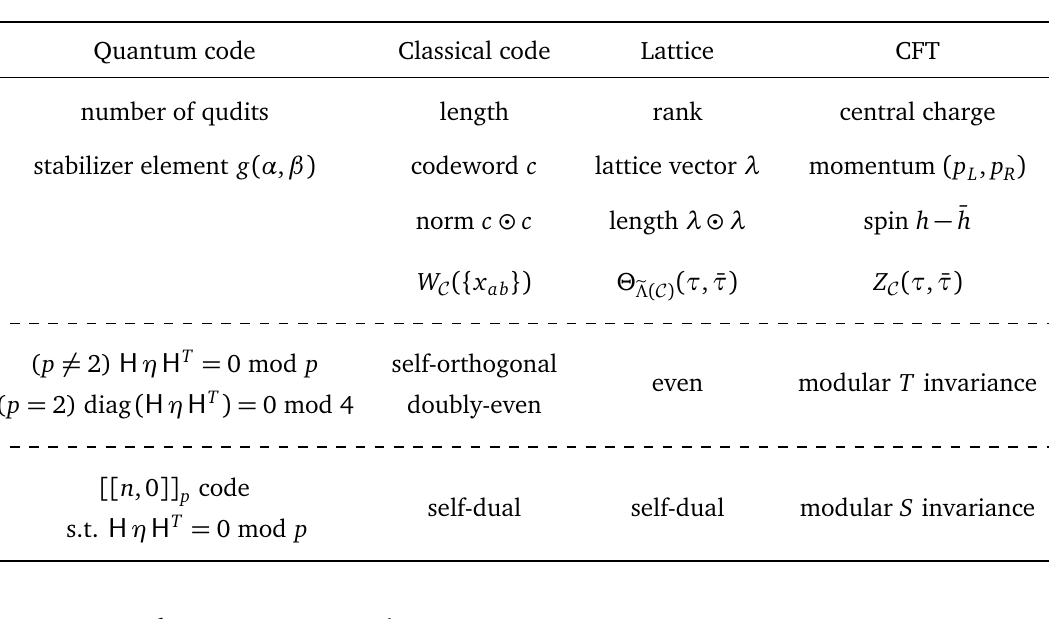
Table 1: The properties of codes, lattices and